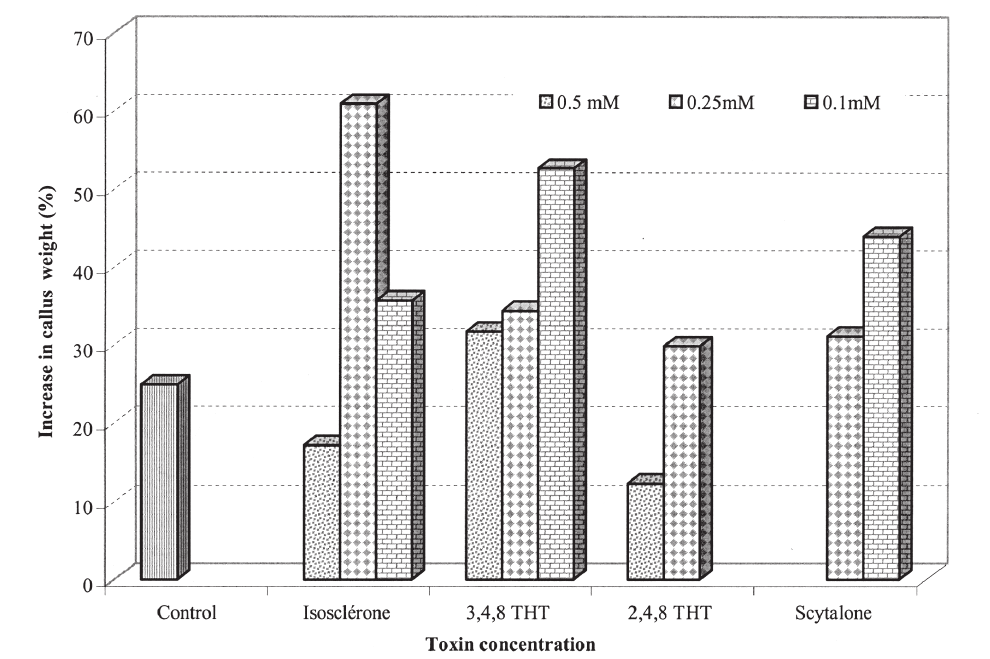
mM).Fig. 2. Effect on the growth of grapevine cv. Gamay callus of the presence of different concentrations of tetralone (3,4,8 THT and 2,4,8 THT) in comparison with scytalone and isosclerone. (Concentrations 0.1 mM of 2,4,8 THT and 0.5 mM of scytalone were not